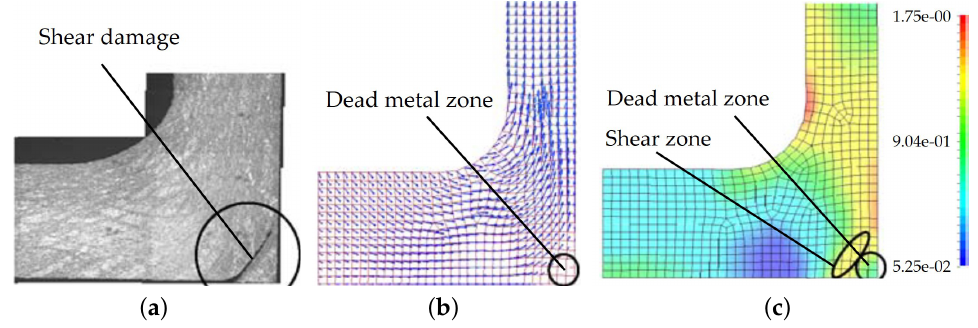
Figure 10. Comparison of shear damage in an AZ31 ( a )forged part, formed at 250 ◦ C, ( b )finite element method (FEM) simulations showing nodal vector displacement and ( c )plastic strain distribution [29]. Reproduced with permission from